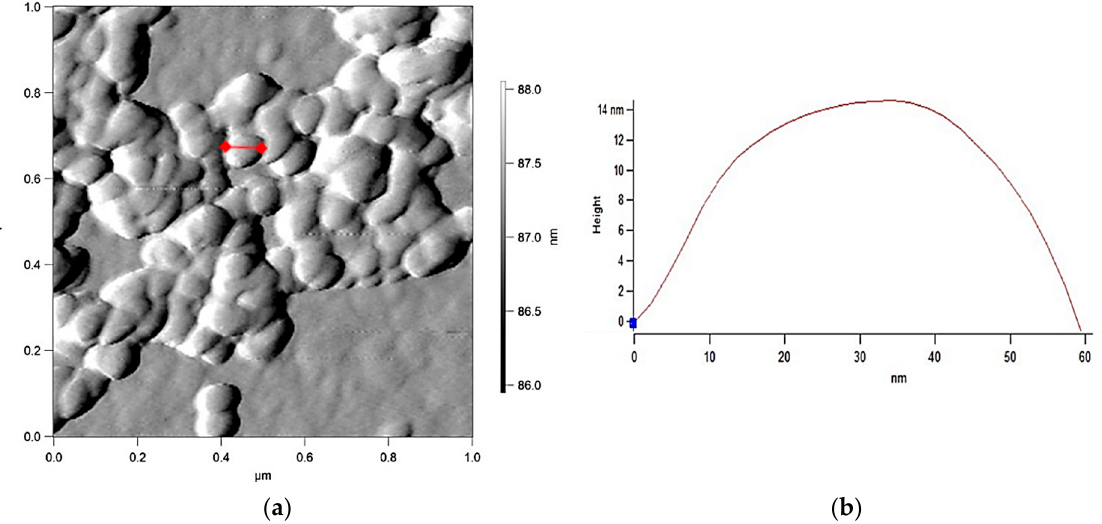
Figure 6. AFM images ( a ) and profilometry ( b ) of AuNPs synthesized by R. erythropolis IEGM 766.